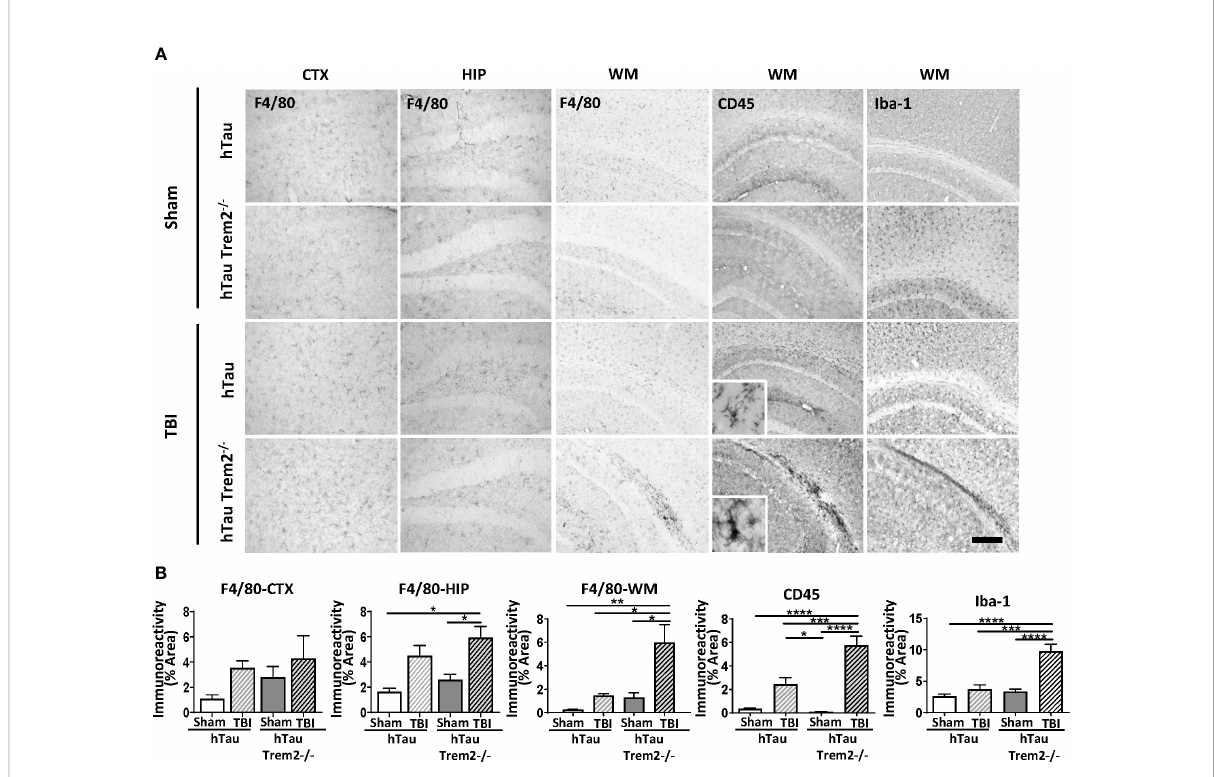
FIGURE 2 HTau; Trem2 -/- TBI mice showed enhanced Iba1, CD45, and F4/80 in the white matter tract near the lesion at 120 DPI. (A) Representative images of CD45, F4/80, and Iba-1 immunostaining in sham and TBI of hTau and hTau; Trem2 -/- mice in the cortex, hippocampus, and white matter tract near lesion site. (B) Quanti fi cation of percent area covered by F4/80, CD45, and Iba-1. TBI signi fi cantly increased this immunoreactivity in hTau; Trem2 -/- TBI mice compared with all other groups in the lateral cortex. All experiments used n = 6 (equal males and females) mice per group unless otherwise noted. At least two independent experiments were performed for each analysis. Scale bar represents 100 m m. Error bars indicate SEM; * p <0.05, ** p <0.01, *** p <0.005, **** p